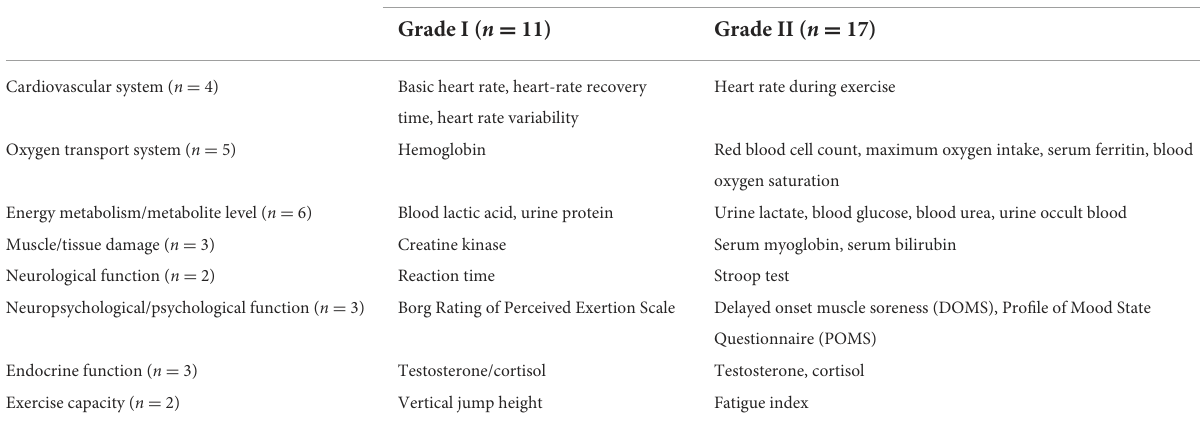
TABLE 6 Recommend